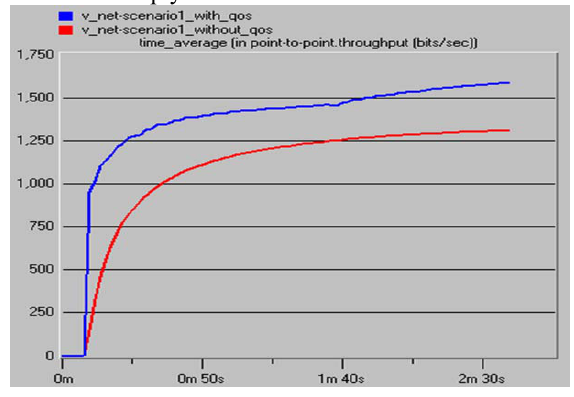
Fig. 12. The comparison result of throughput Under the condition of light tr affic, thr oughput of